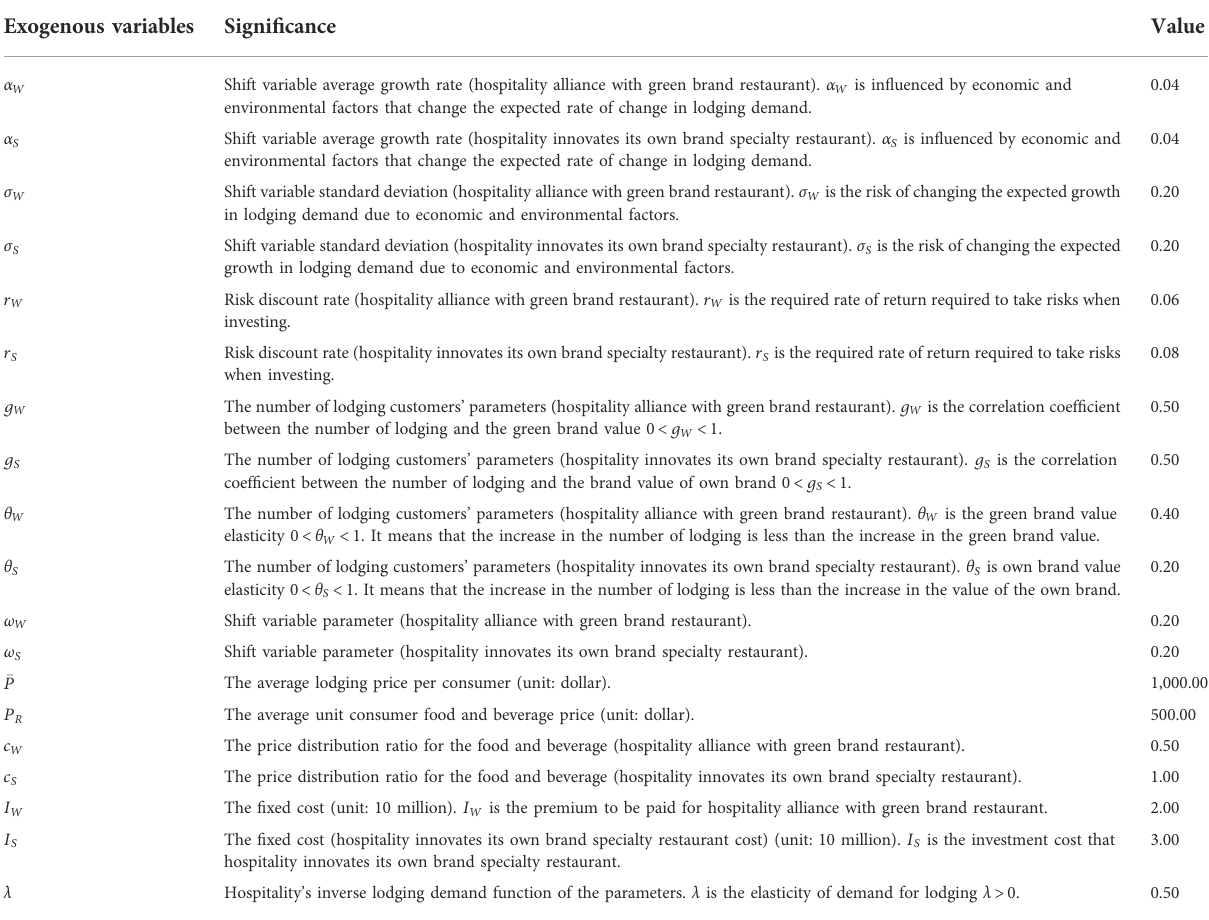
TABLE 1 Exogenous variables. Exogenous variables